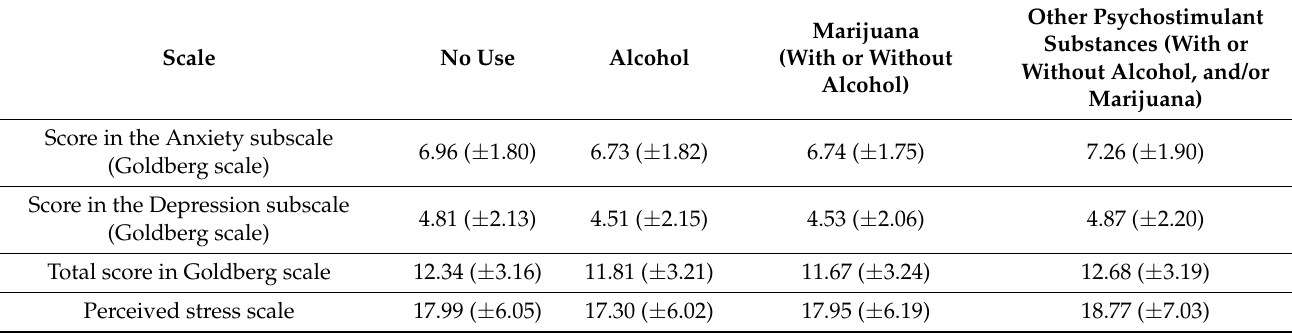
Table 6. Mean score for anxiety, depression and perceived stress as a function of substance use.